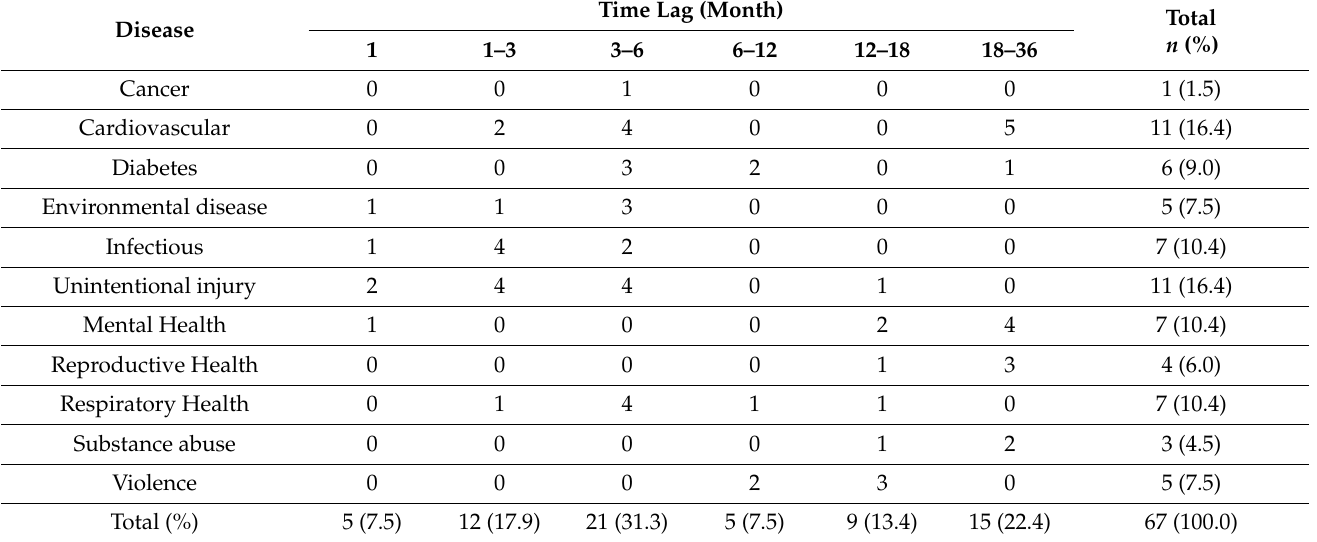
Table 2. Disease frequency by time-lag between disease occurrence (or reporting) and date of hurricane impact (or landfall) (percentages in